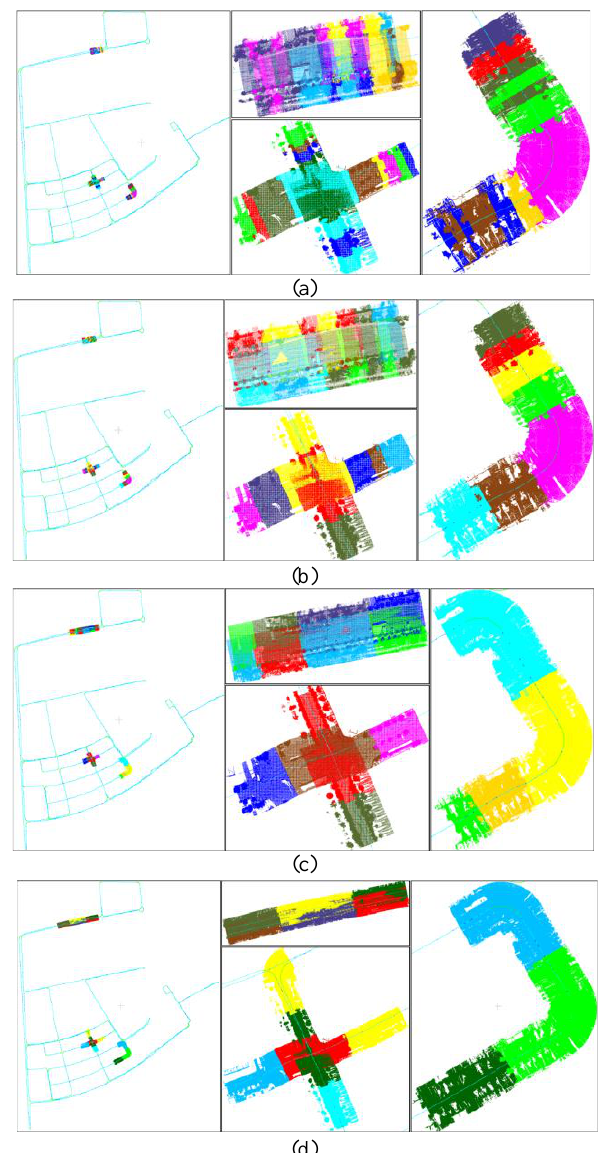
Figure 6. Result of point cloud partition, segment length is (a) 5m, (b) 10m, (c) 20m, (d) 40m. The left column is top view of segments; the upper center shows the segments at round-trip; the down center shows the segments at crossroads, and the right column shows the segments at